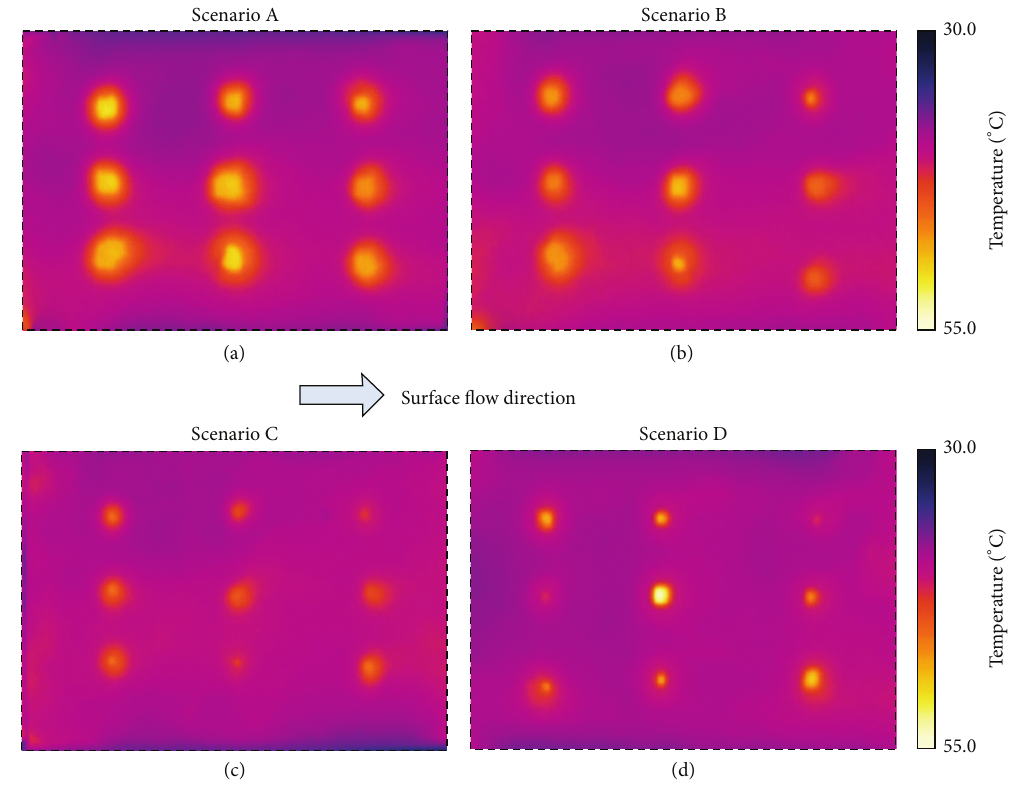
Figure 3: Thermograms of the soil surface for the four scenarios: (a) Scenario A; (b) Scenario B; (c) Scenario C; and (d) Scenario D. The dashed line defines the measuring area with 0.50 × 0.30 m 2 . See also Figure